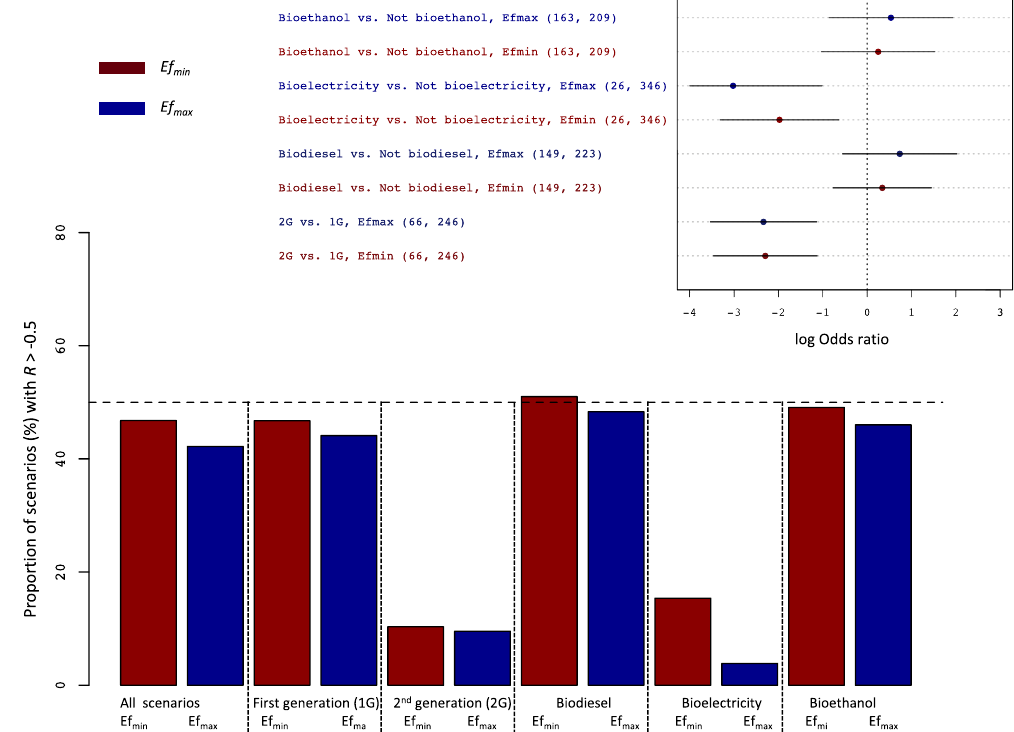
Figure 4. Proportion of scenarios with an effect size value R larger than − 0.5 ( ie , with a GHG abatement under 50%), and estimated differences in the logarithm of the odds ratio between groups of scenarios corresponding to different types of bioenergy (top inset). The odds ratio is calculated as the proportion of scenarios with an R value greater than − 0.5 divided by the proportion of scenarios with an R under − 0.5. Either the